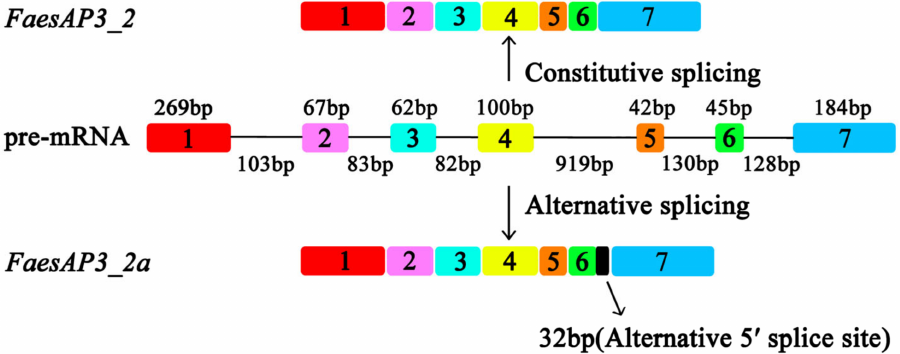
Figure 2. Alternative splicing of FaesAP3_2. Color boxes indicate exons while black lines indicate introns of FaesAP3_2